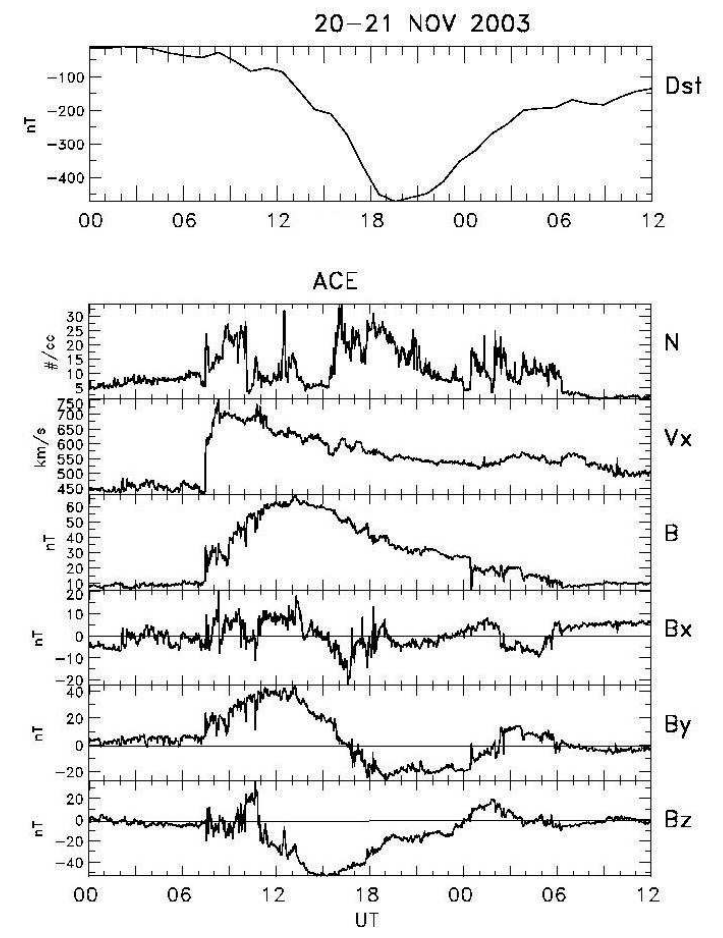
Fig. 1. D st index and IMF parameters from ACE (240, 22, –15 R E